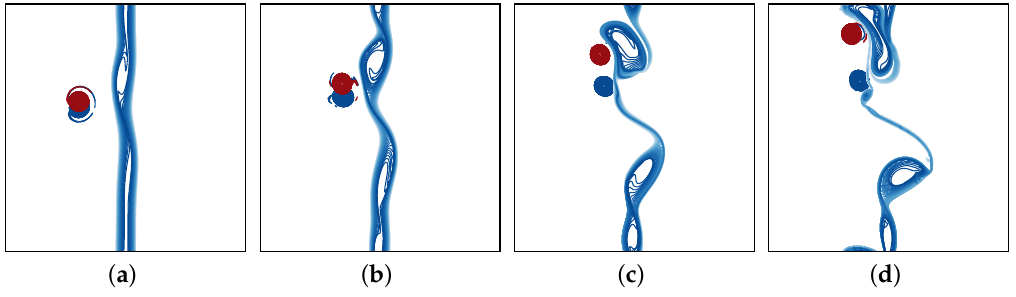
Figure 10. Case 2.2: effect of decreasing the mean depth H of the heton from 4 a to 2.04 a . Top view of the flow showing contours of buoyancy and PV at t = 14, 20, 26 and 40 from ( a ) to ( d